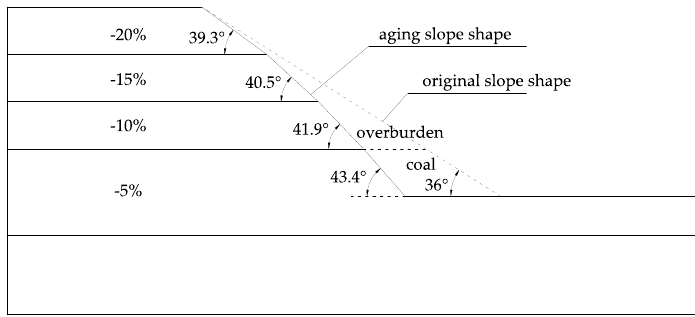
Figure 12. Long-term aging slope model.